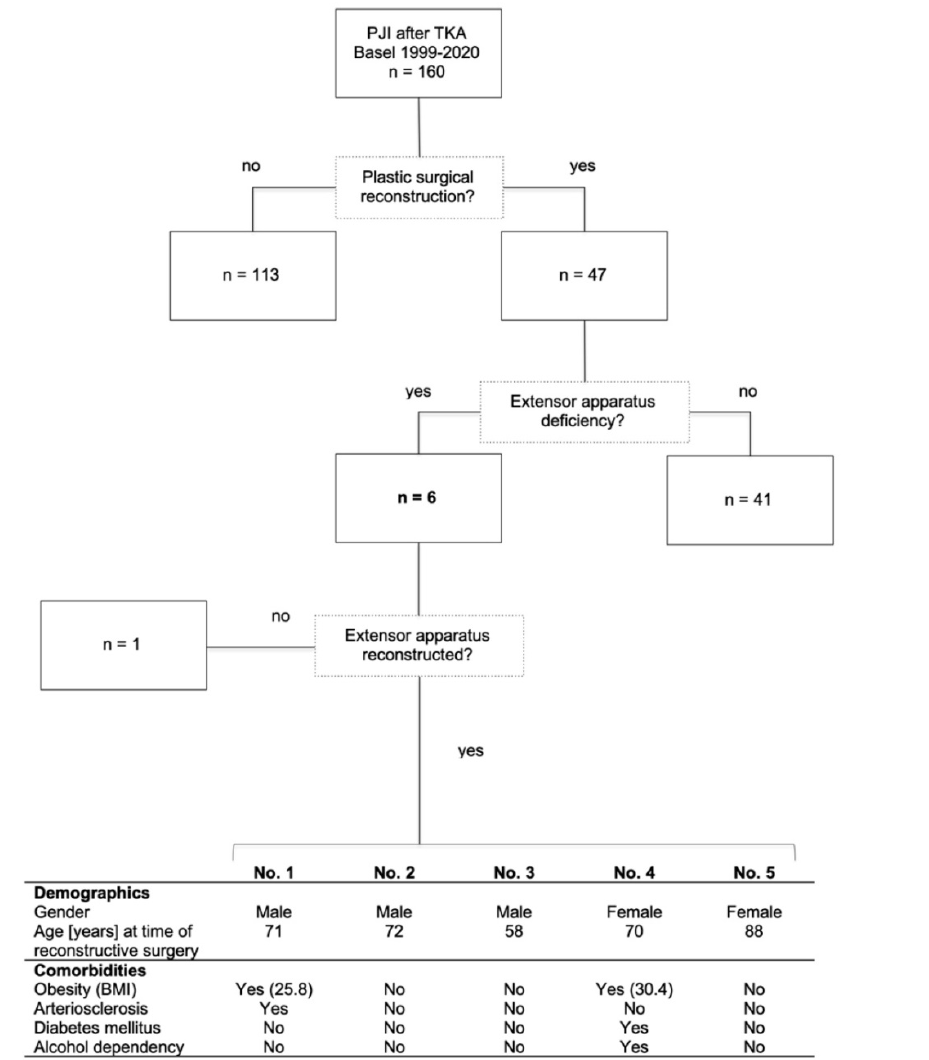
Figure 2: Inclusion criteria and patient demographics. PJI: periprosthetic joint infection; TKA: total knee joint arthroplasty; BMI: body mass index [kg/m 2